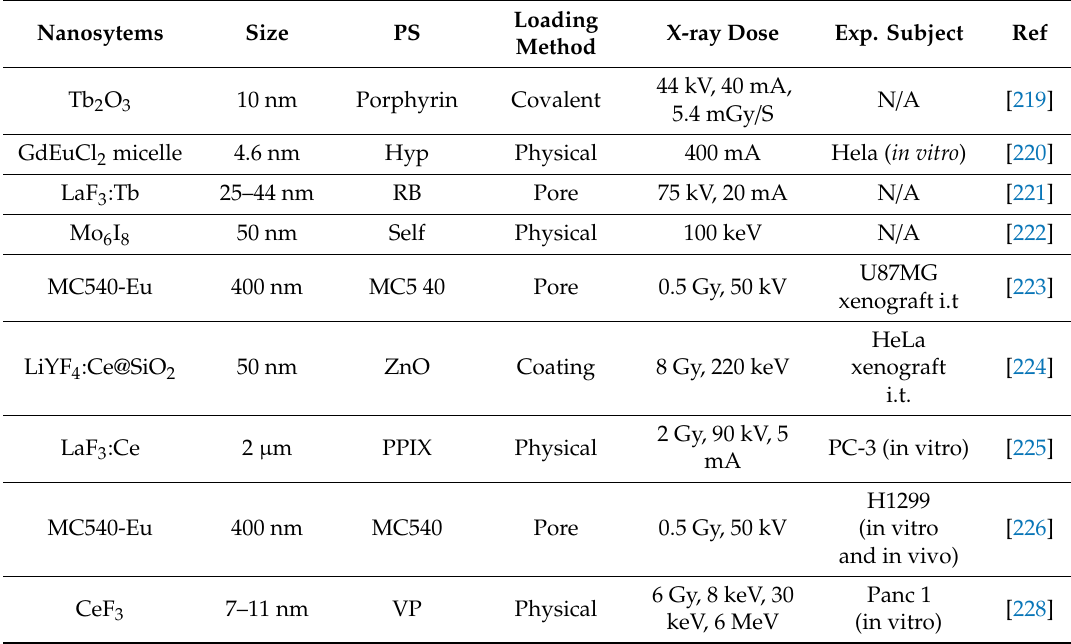
Figure 7. Radioisotopes can emit Cerenkov radiation to directly activate photosensitizer (PS) that can absorb light in the 200 − 500 nm range. Some radioisotopes can generate high-energy photons, such as γ -radiation, which can be absorbed by certain types of NP (i.e., scintillating NP). In this case, the PS will be indirectly excited by the radionuclide. Once the PS is activated, reactive oxygen species (ROS) will be generated to damage the surrounding cell / tissue. Reproduced with permission from Reference [216]. Table 3. X-ray scintillators for cancer